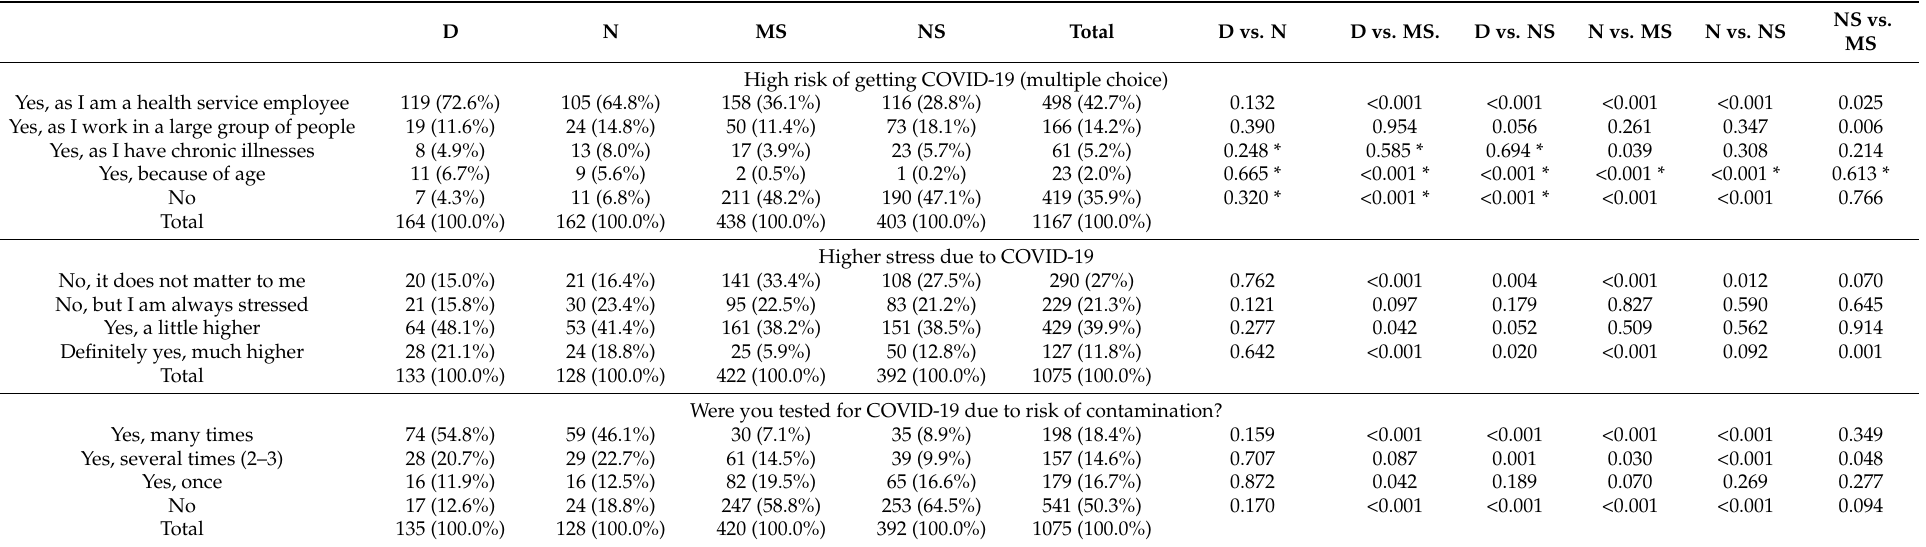
Table 1. Risk assessment of morbidity and the stress associated with